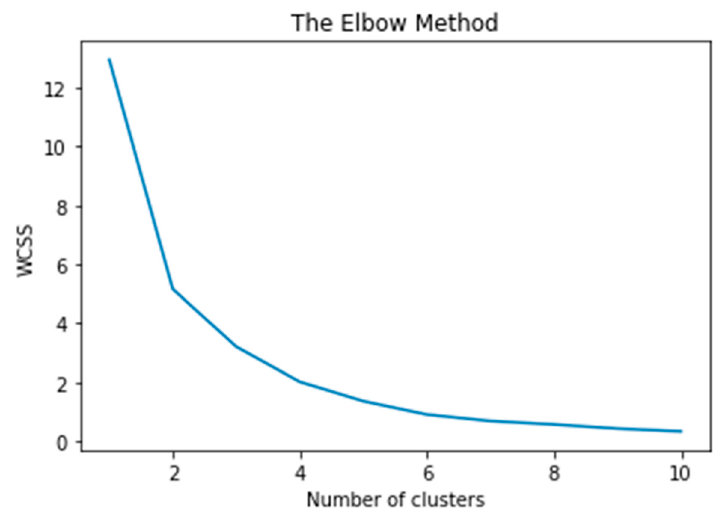
Figure 6. K-means clustering effect analysis.